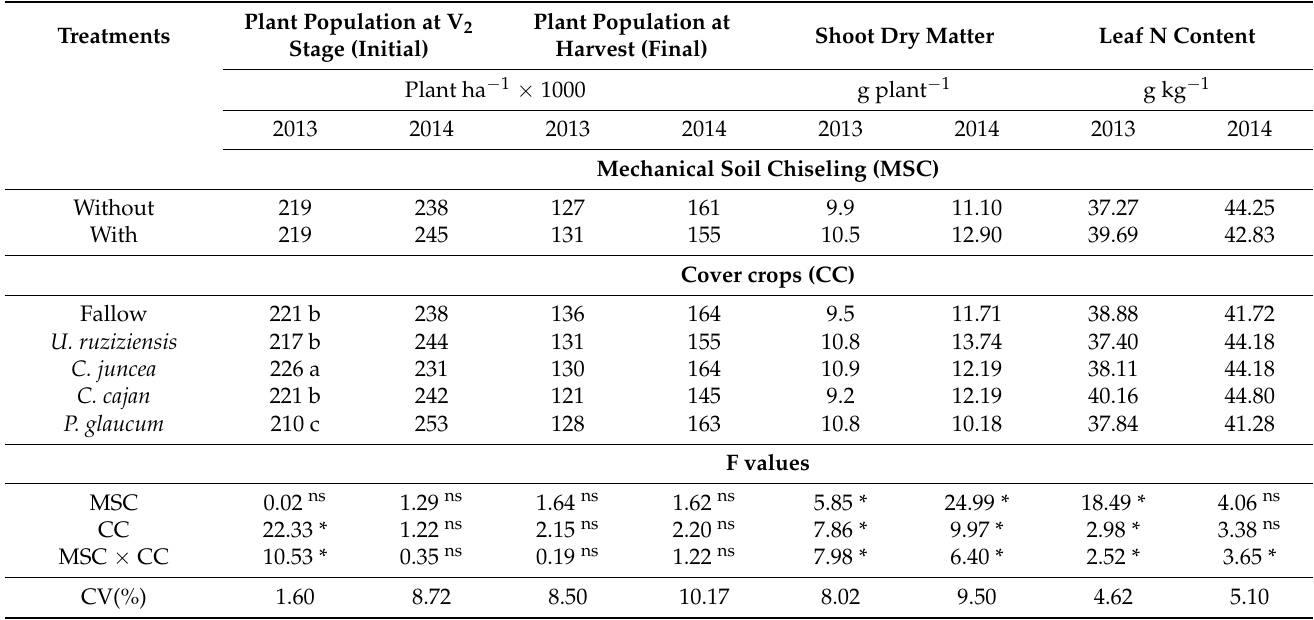
Table 2. Mean values of initial and final plant population, shoot dry matter, and leaf nitrogen (N) content of “winter” common bean after mechanical decompaction and predecessor cover crops, MS- Brazil, 2013 and